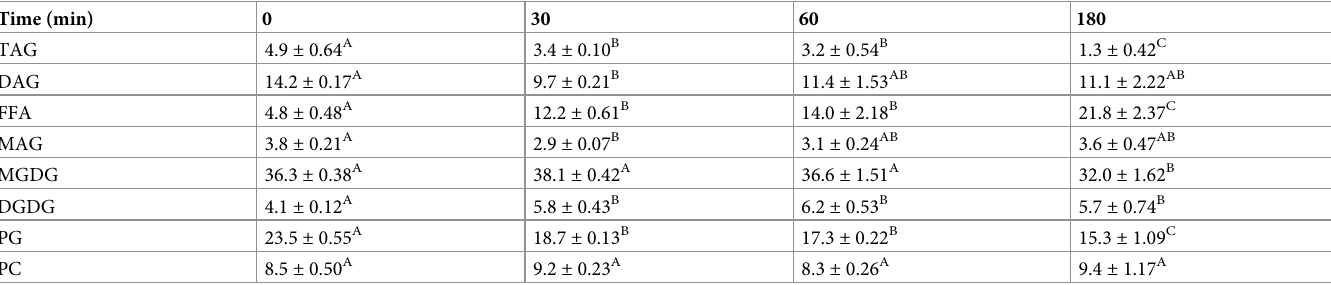
A,B,C (Results in the same row sharing superscripted letters are not significantly different (P � 0.01)). Triacylglycerol (TAG), diacylglycerol (DAG), free fatty acids (FFA), monoacylglycerol (MAG), monogalactosyldiacylglycerol (MGDG), digalactosyldiacylglycerol (DGDG), phosphatidylglycerol (PG), phosphatidylcholine